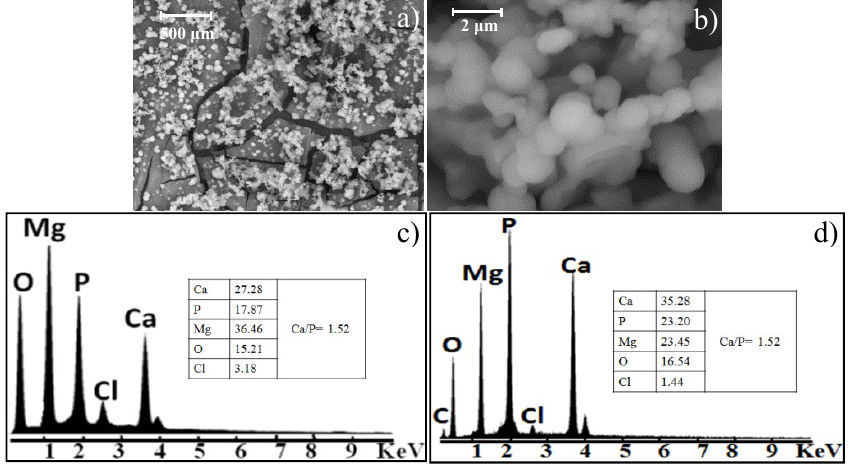
Figure 6. SEM images and corresponding EDS analysis of the Mg-0.375Ga alloy after 168 h of immersion in SBF: ( a ) 50× and ( b ) 5000×.